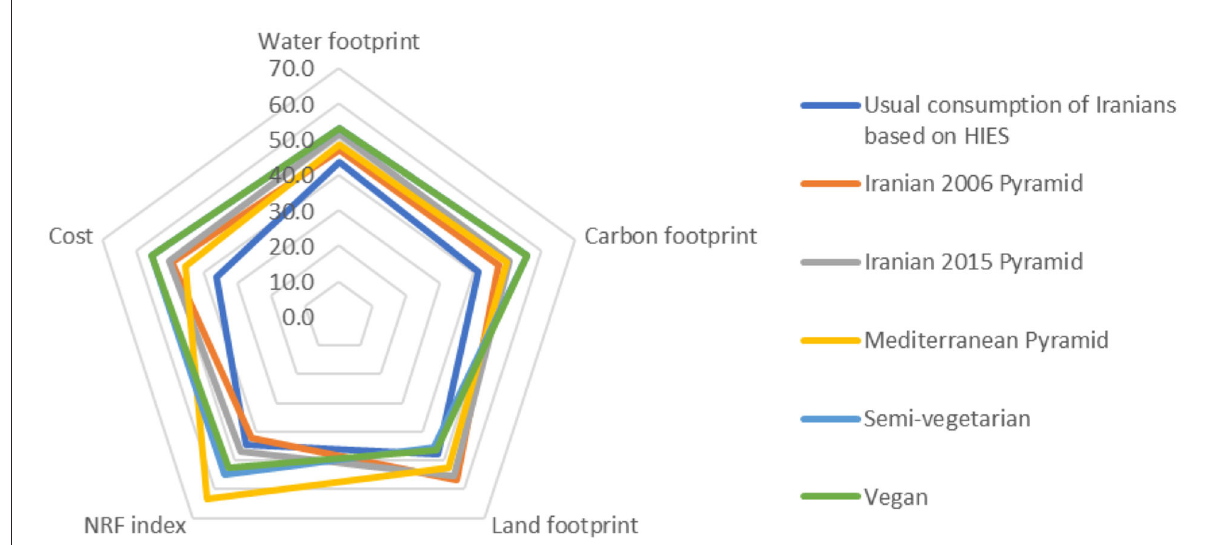
FIGURE1 Comparison of dimensions of sustainability for the usual diet of Iranians and the optimized five sustainable diet